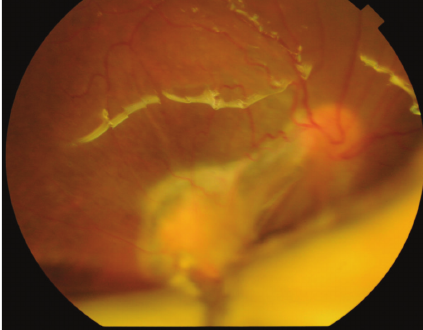
Figure 6: Color photo of left eye showing macular exit with retinal